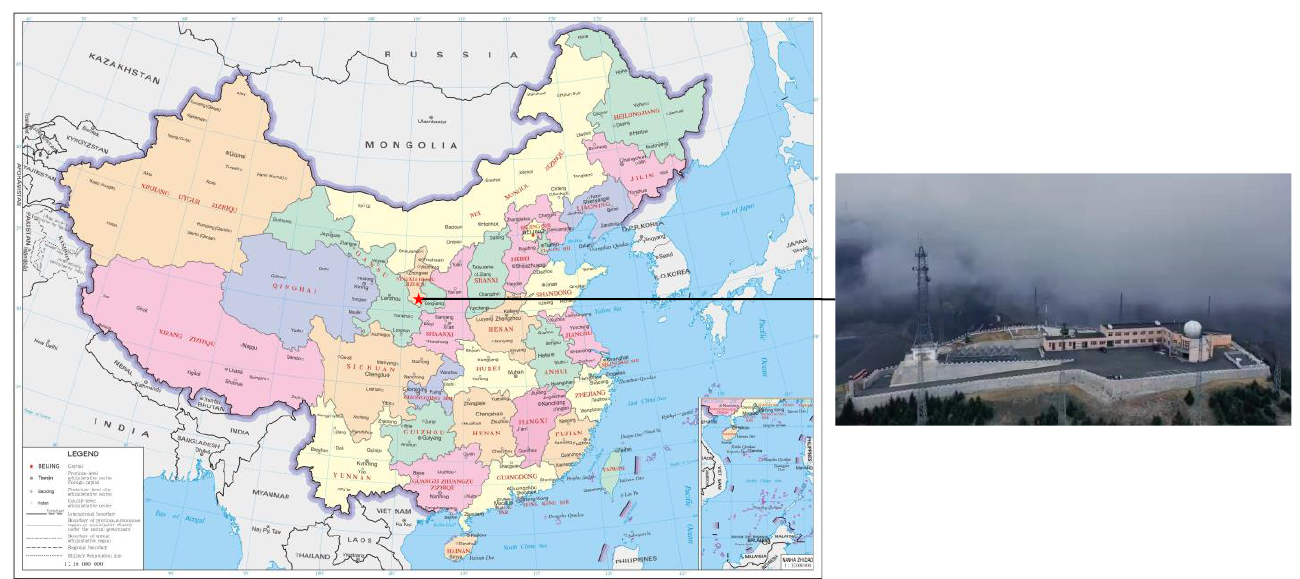
Figure 1. Site location of LPS Meteorological Observation Station, Ningxia Hui Autonomous Region, China (Drawing approval number: GS(2019)1696).